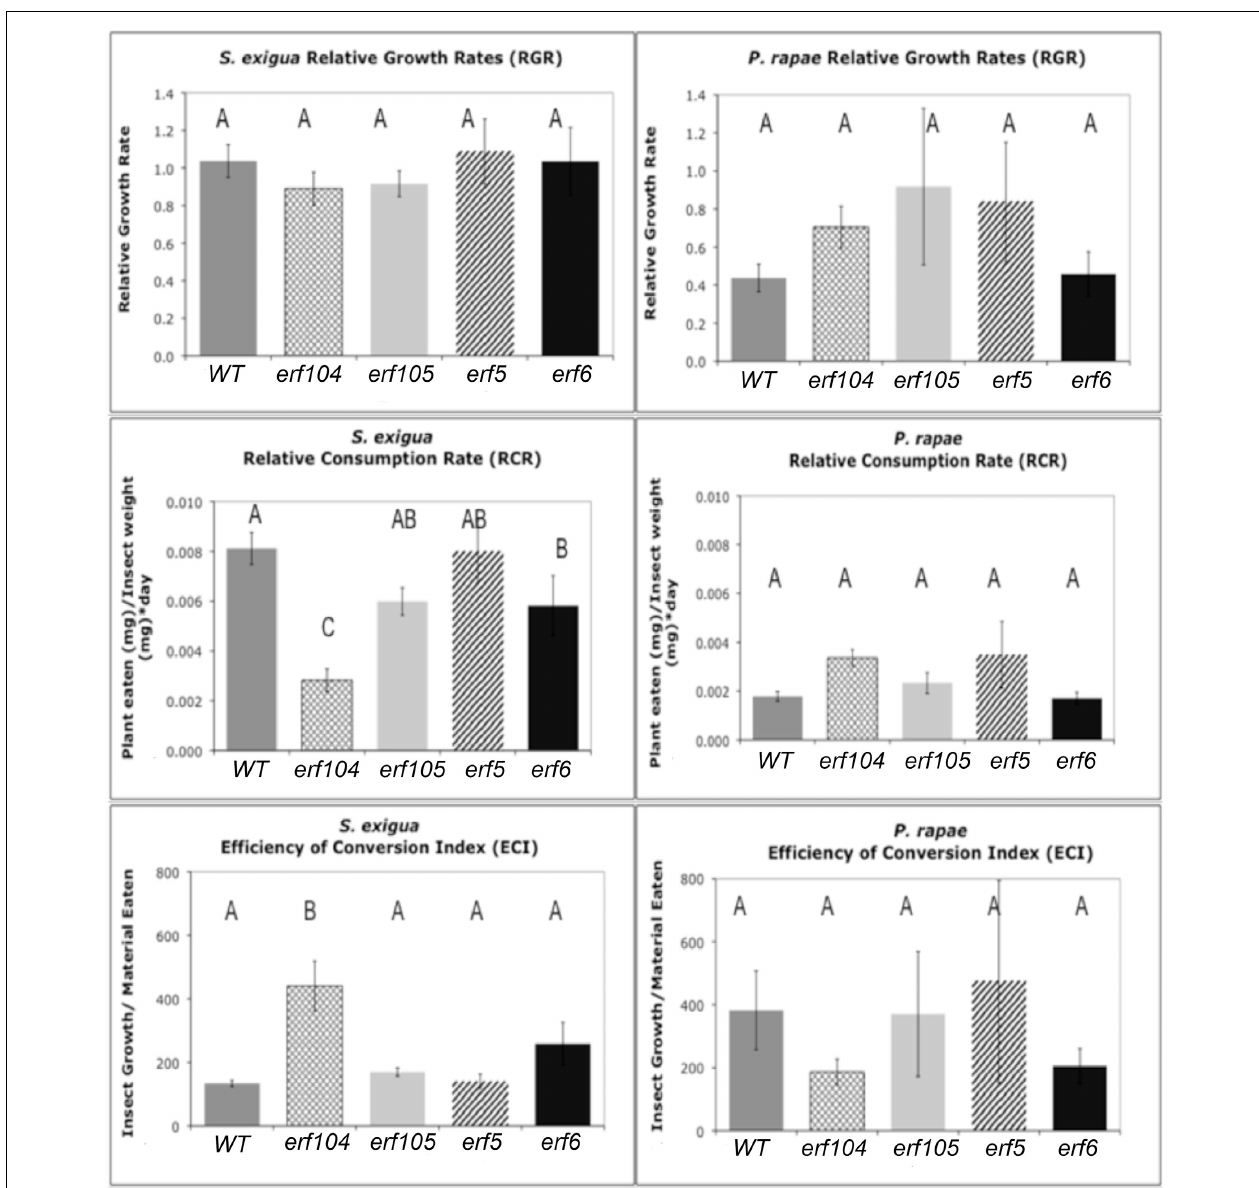
FIGURE 6 | S. exigua and P. rapae relative growth rates (RGR), relative consumption rates (RCR), and efficiency of conversion of ingested food index (ECI) on WT and erf mutant plants. RGR represents the total weight gained by an insect relative to its initial weight and total feeding time. RCR is calculated as the total material (mg) eaten divided by initial insect weight (mg) multiplied by the feeding period (days). ECI is calculated as the